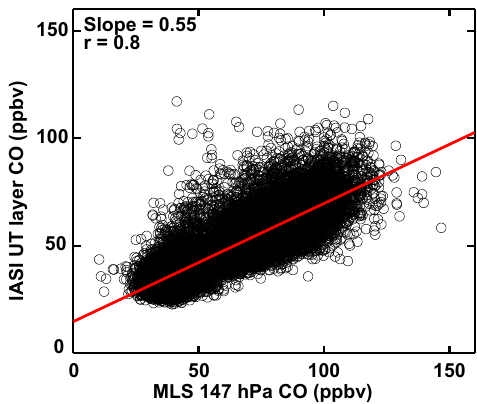
Figure 3. Scatter plot of IASI UT layer CO versus MLS 147hPaCO for June, July, and August (JJA) 2008. Each data point represents a daily average of CO level 2 data from IASI and MLS in the same 10 ◦ × 6 ◦ longitude–latitude box in the study domain. The red line shows a linear fit. Correlation and slope for the linear fit are given in the upper left corner of the